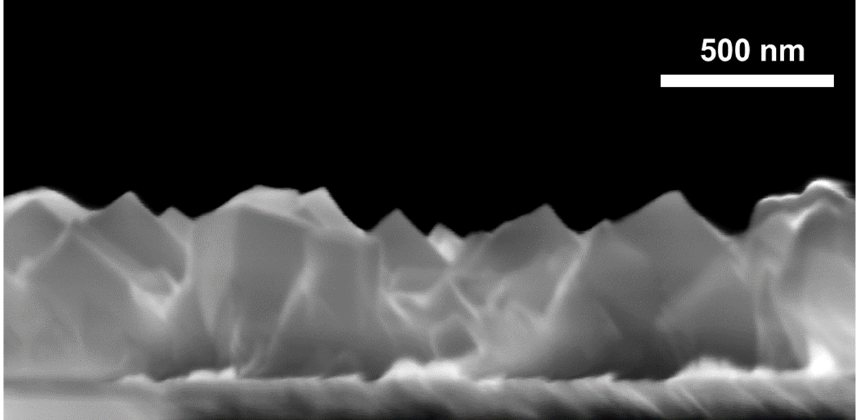
Figure 2. Cross ‐ section electron microscopy image of the PW